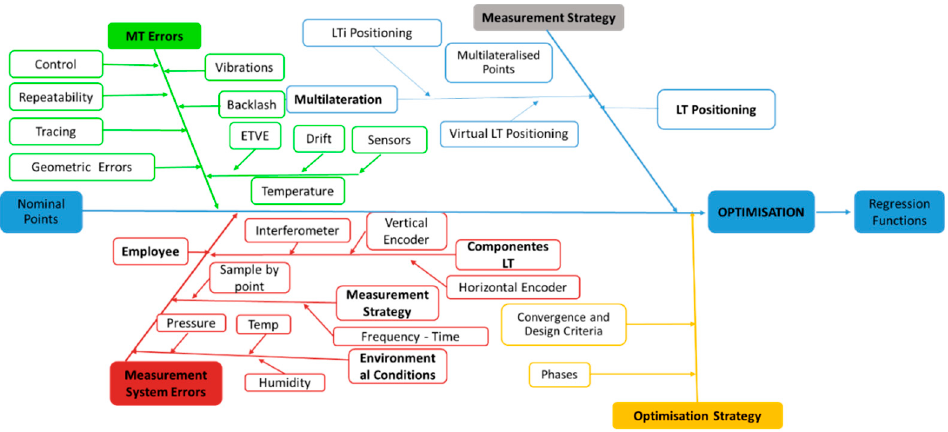
Figure 3. Uncertainty sources in MT verification when it is used as a measurement system. LT is laser tracker.